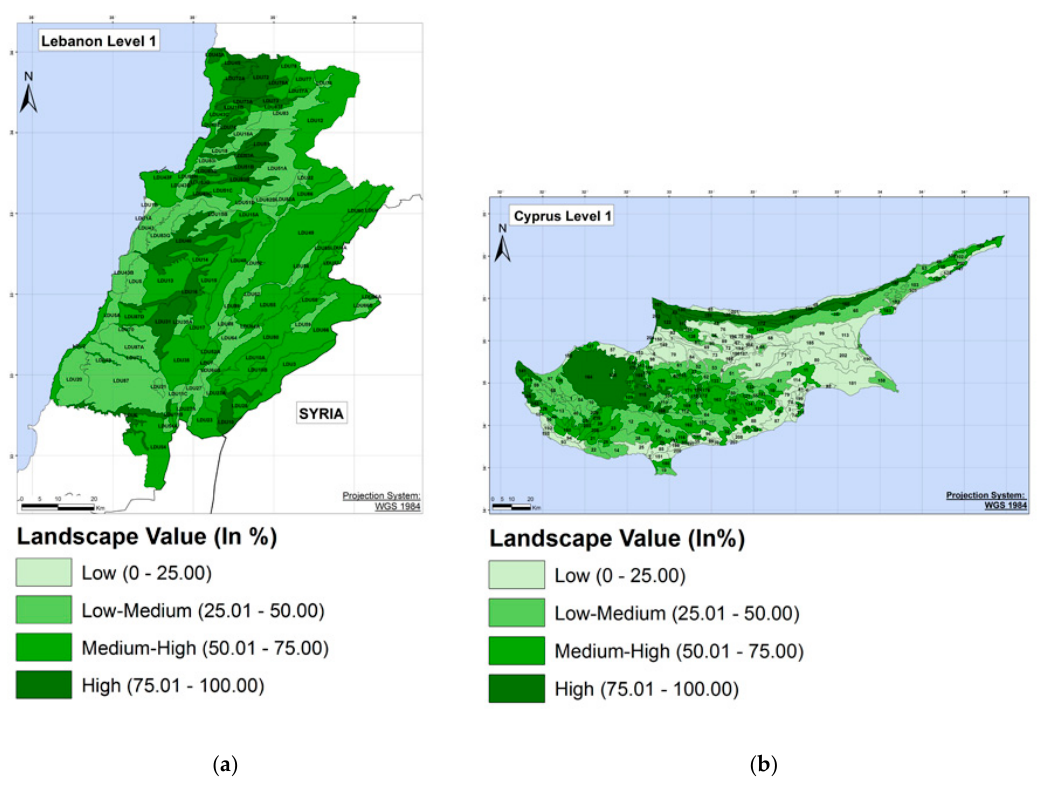
Figure 16. Landscape Value (LV) maps in ( a ) Lebanon and ( b ) Cyprus.